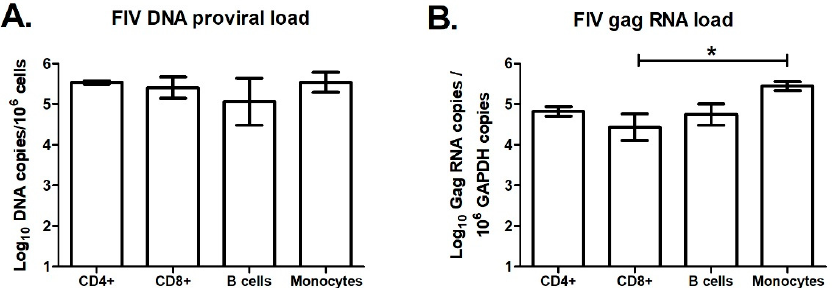
Figure 8. FIV is pancytotropic and replicates in monocytes and lymphocytes. PBMCs were isolated from three chronically FIV-infected cats (18-weeks post infection) and cells were sorted by fluorescence-activated cell sorting (FACS) into CD4+, CD8+, B cell (B220+), and monocyte (CD14+) subsets. FIV DNA proviral load ( A ) and FIV gag RNA load ( B ) in each of these cell subsets were determined by qPCR. CD8+ cells had significantly lower FIV gag RNA than monocytes (*, p < 0.05). All other differences between groups were non-significant. Error bars represent standard errors of the means.